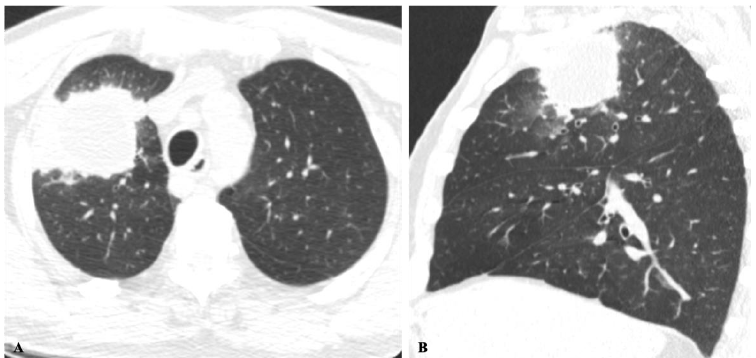
Figure 3. Cryptococcosis in a 63-year-old man with clinical history of colon cancer, heavy smoking and cough for 3 months. ( A ) Axial and sagittal ( B ) images show an irregular solid mass in the right upper lobe adjacent to the pleura and ground-glass halo.